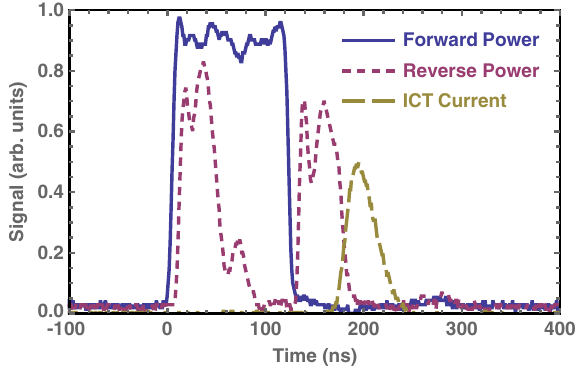
FIG. 4. Scope traces of forward power (blue solid line), reverse power (purple fine dashed line), and ICT current (yellow coarse dashed line) for a typical breakdown shot.